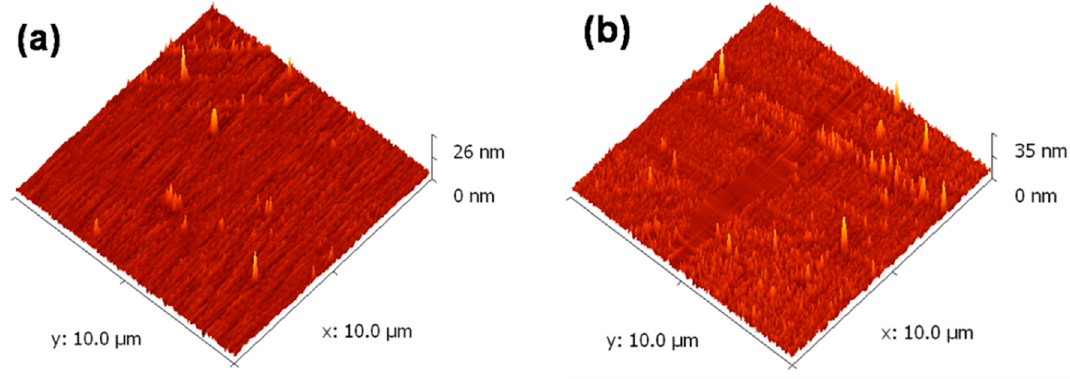
Figure 8. Surface topographies of Mo-DLC coatings on Si substrate: ( a ) 3.9 at.% Mo and ( b ) 16.2 at.% Mo.